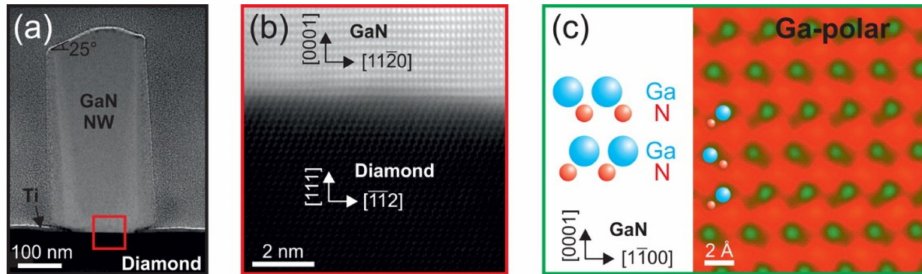
Figure 12. ( a ) STEM image of a GaN NW grown on the diamond substrate. ( b ) The heterointerface between diamond and GaN. ( c ) High-resolution STEM image of the GaN nanowire. Reproduced from [124], with permission from Copyright American Chemical Society,